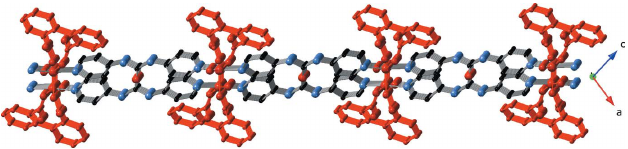
Figure 4 A side-view perspective of the two-dimensional [Cu(H 2 O)(dip)(bpu)] n